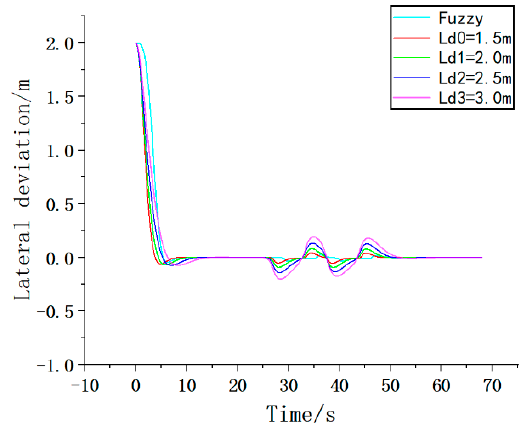
Figure 14. Variation of lateral deviation.